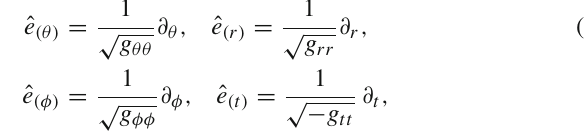
Fig. 3 Location of the curvature singularity r cs (black curve), the pho- ton sphere r ph (orange curve), and the inner and the outer marginally stable orbits r − and r + (in blue and red, respectively) as a function of the solution parameter γ . For γ = 1 / 2 (point P ) the positions of the curvature singularity, the photon sphere, and the inner marginally stable orbit coincide. For lower values of γ no photon sphere exists, and a second region of stability of the circular geodesics develops. For √ γ = 1 / 5 (point Q ) the two marginally stable orbits merge, and for √ γ < 1 / 5 all the circular geodesics are